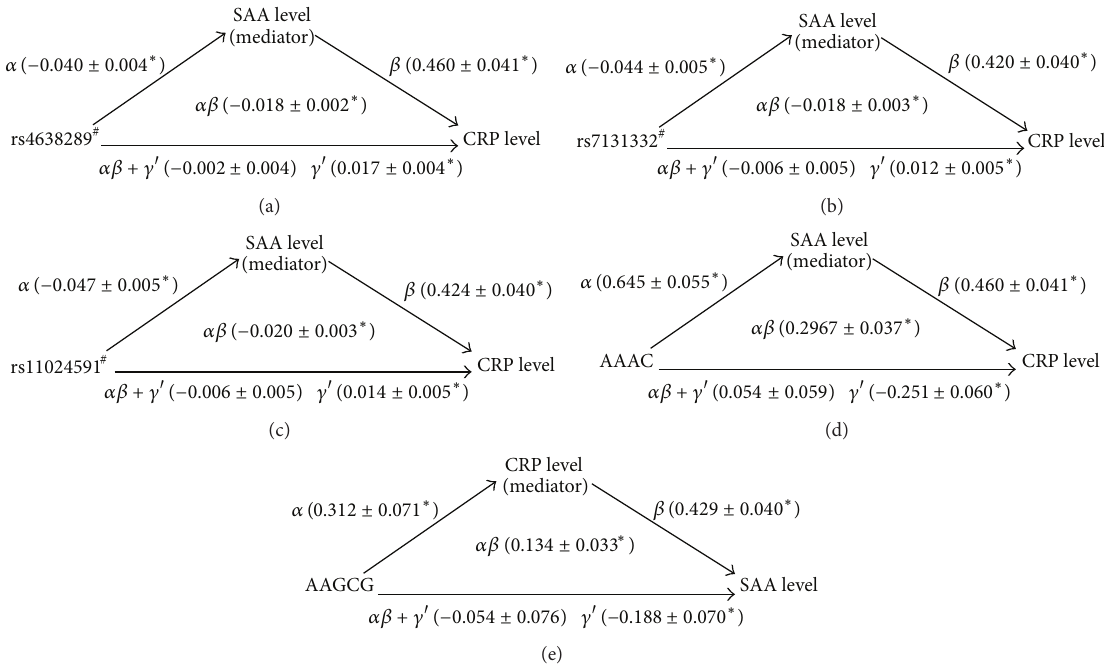
Figure 2: A three-variable mediation model: SAA and CRP levels as a mediator of the association between the SAA and CRP genotypes/haplotypes and CRP and SAA levels. Linear regression models were used to assess the following path associations: in Figure 1(a): ( 𝛼 ) relationship between the SAA genotype and SAA level, ( 𝛽 ) relationship between SAA level and CRP level, ( 𝛼𝛽 + 𝛾 󸀠 ) relationship between the SAA genotype and CRP level, and ( 𝛾 󸀠 ) relationship between the SAA genotype and CRP level after adjustment for SAA levels. Each estimate along the path represents the unstandardized 𝛽 coefficient from the regression model. The results indicate that, after adjustment for SAA levels, the SAA genotypes exhibited a stronger association with CRP level. The direct effects ( 𝛾 󸀠 ) of the SAA genotypes on the CRP level (0.017) were greater than the total effects ( 𝛼𝛽 + 𝛾 󸀠 ) ( − 0.002) and revealed similar magnitudes and opposite signs than those of the mediation effects ( 𝛼𝛽 ) ( − 0.018), suggesting significant mediation (suppression) by the SAA levels. All of the models were adjusted for age, sex, BMI, current smoking status, and medications for hypertension, diabetes mellitus, and dyslipidemia. ∗ 𝑃 < 0.05 . In addition, the other analysis exhibited similar suppression effects ((b), (c), (d), and (e)). # SAA